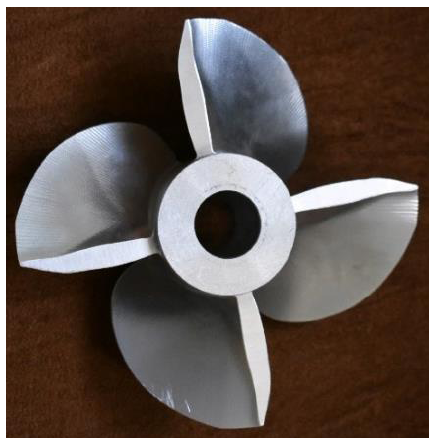
Table 5. Test parameters.